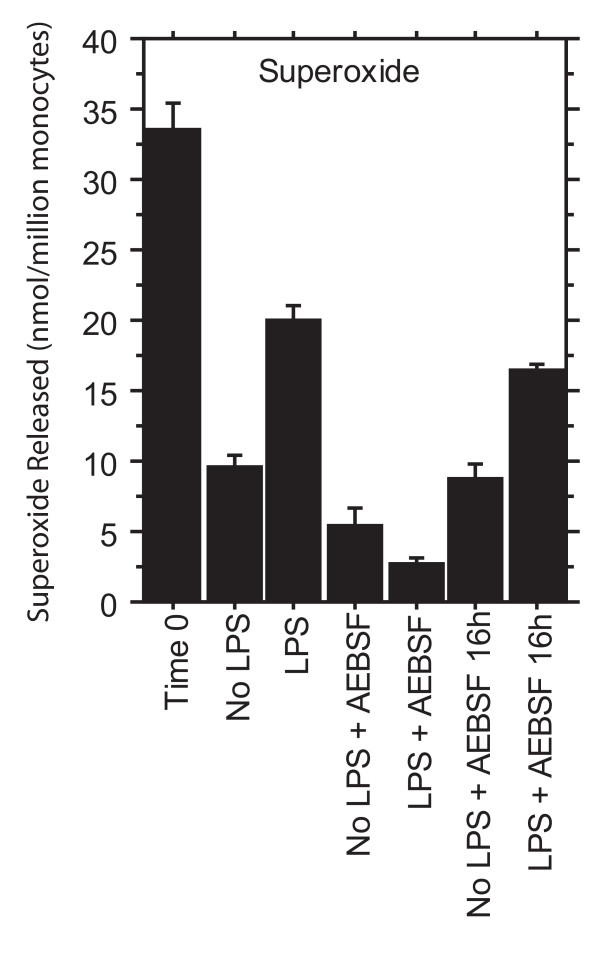
Effects of LPS and AEBSF on phorbol-triggered superoxide release. Phorbol myristate acetate-triggered release of superoxide from monocytes cultured for 16 h ± LPS ± AEBSF. The first bar is Time 0, a control of monocytes at the start of culture when they were still agitated by the isolation procedure. The last two bars show the effect of AEBSF added at the end of the culture at 16 h. LPS primed monocytes for enhanced release of superoxide; AEBSF blocked priming. Means ± SE, n = 4.